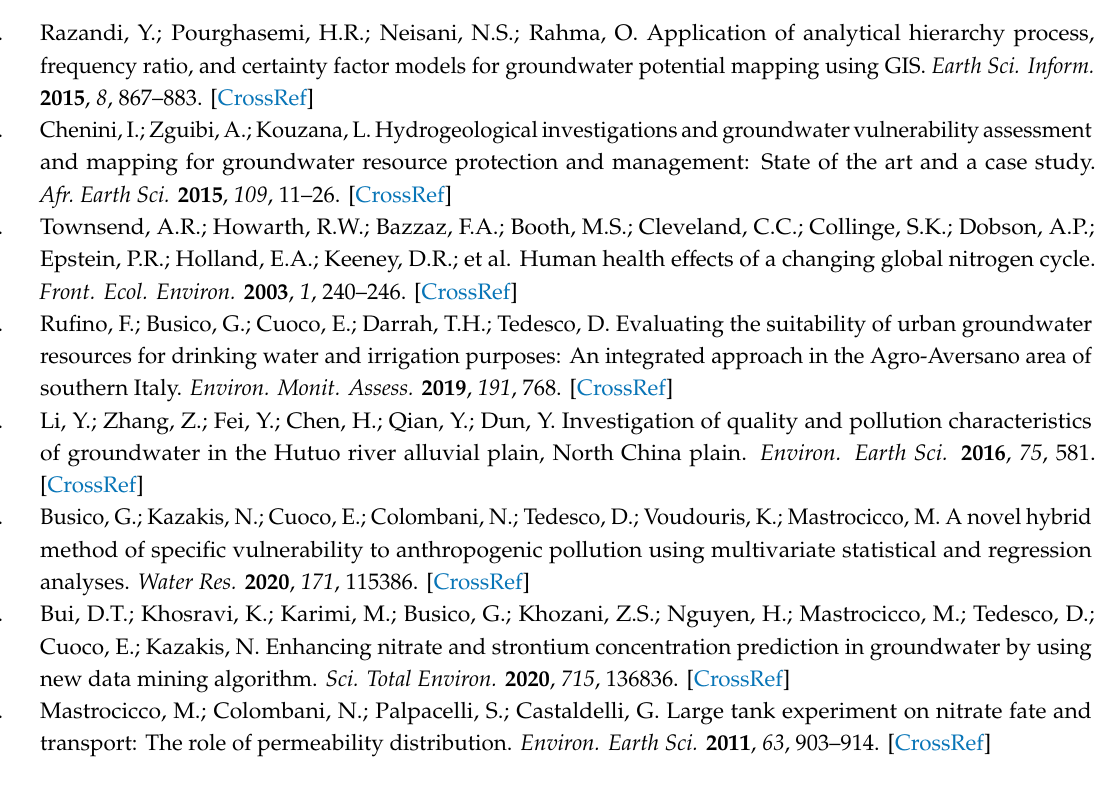
Table S1: Ranking scheme of the hazard factors (HF) and the control factors (CF). The former are referred to agricultural activities which produce or may produce impacts on the aquifers; the latter are referred to parameters which modify the hazard factors in positive, negative, or null way. Table S2: Nitrogen supply from the di ff erent adopted crops. Table S3: HFfm scores for the di ff erent crops recognized in the study area, based on CUAS. Table S4: HFfm scores for the di ff erent crops recognized in the study area, based on CUAS. Table S5: The main soil types found and relationship between soil and nitrate concentration. Table S6: Correlation between CUAS type and fertilization type. Table S7: Correlation between CUAS type and irrigation systems. Appendix: Land System of Campania